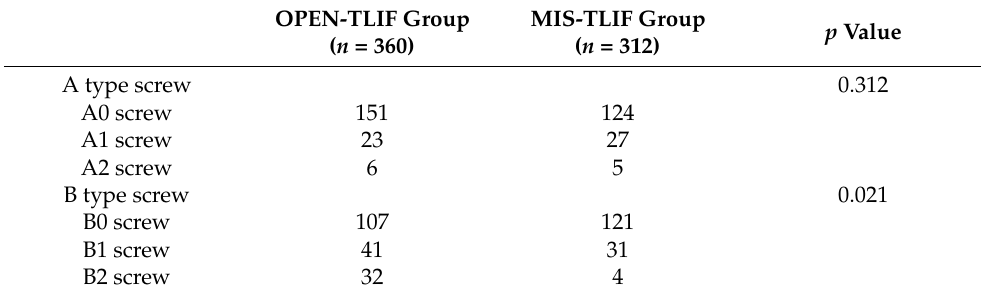
Table 6. Distribution of screw types of the two groups according to RAO grading.